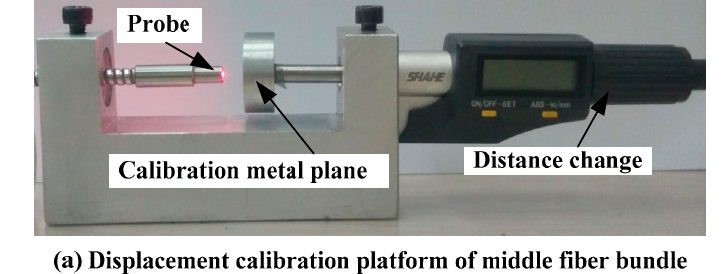
Figure 15. Ratio-displacement curves of the two receiving fibers.